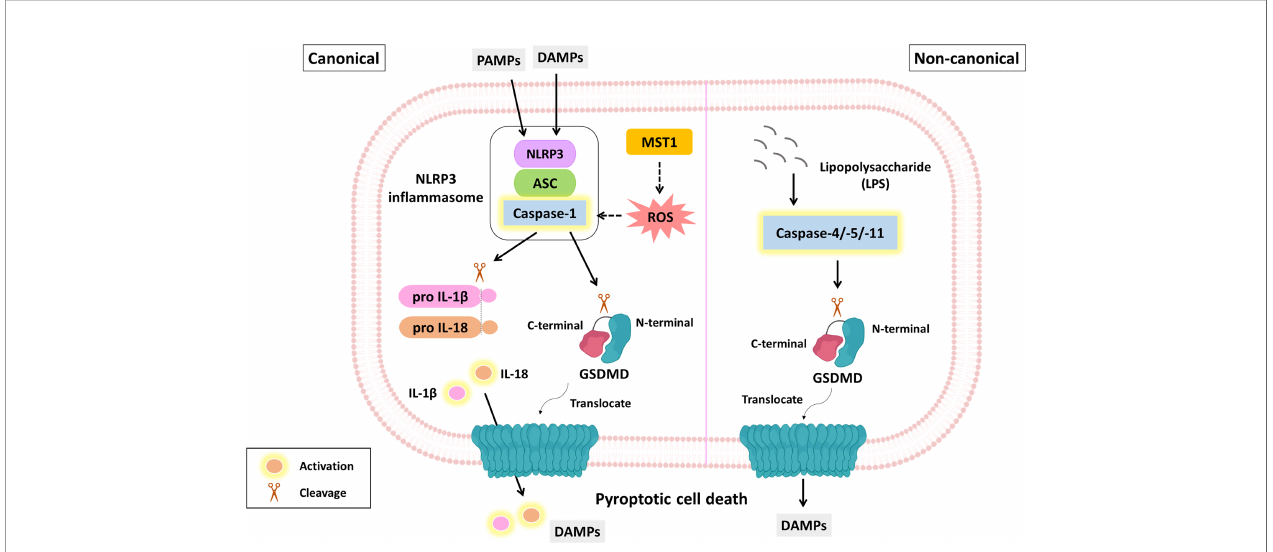
FIGURE 3 | The molecular mechanism of pyroptosis and its role in PDAC suppression. The molecular mechanism of pyroptosis is mainly divided into canonical and noncanonical pathways. The canonical pathway (left panel) is triggered by DAMPs or PAMPs. This process facilitates the formation of in fl ammasomes, including PRRs (e.g., NLRP3), ASCs and procaspase-1. Activated caspase-1 not only cleaves GSDMD but also contributes to IL-1 b and IL-18 maturation. The GSDMD N- terminus is translocated to the plasma membrane where it oligomerizes to form a lytic pore. MST-1 is a component of the Hippo signaling pathway and has been reported to induce caspase-1-dependent pyroptosis via ROS. The noncanonical pathway (right panel) is initiated by LPS and executed by caspase-4/-5/-11 not caspase-1, eventually leading to GSDMD cleavage and membrane pore formation. Yellow fl uorescence represents active